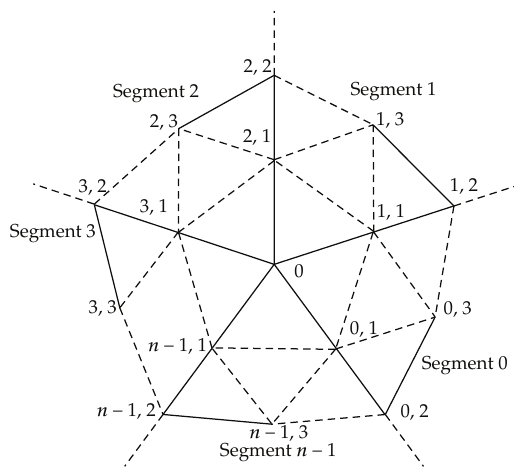
Figure 2: The subdivision stencil for continuity